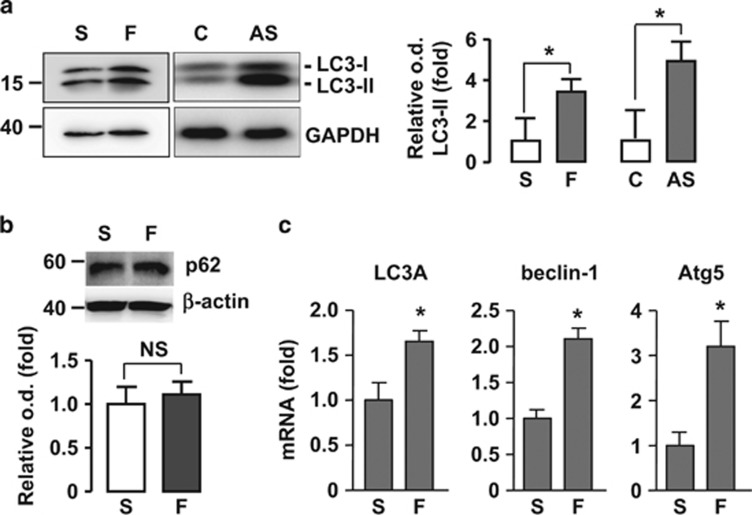
Effects of laminar flow (20 dyn/cm2) on (a) LC3 level, (b) p62 level, and (c) mRNA levels of LC3A, beclin-1, and Atg5. In a, autophagy induction by amino-acid starvation (by treating cells with Hank's balanced salt solution for 4 h) was used as a positive control. Data are mean±S.E.M. *P<0.05, unpaired t-test, n=3–4. C, control; S, static; F, flow; NS, no significance; AS, amino-acid starvation